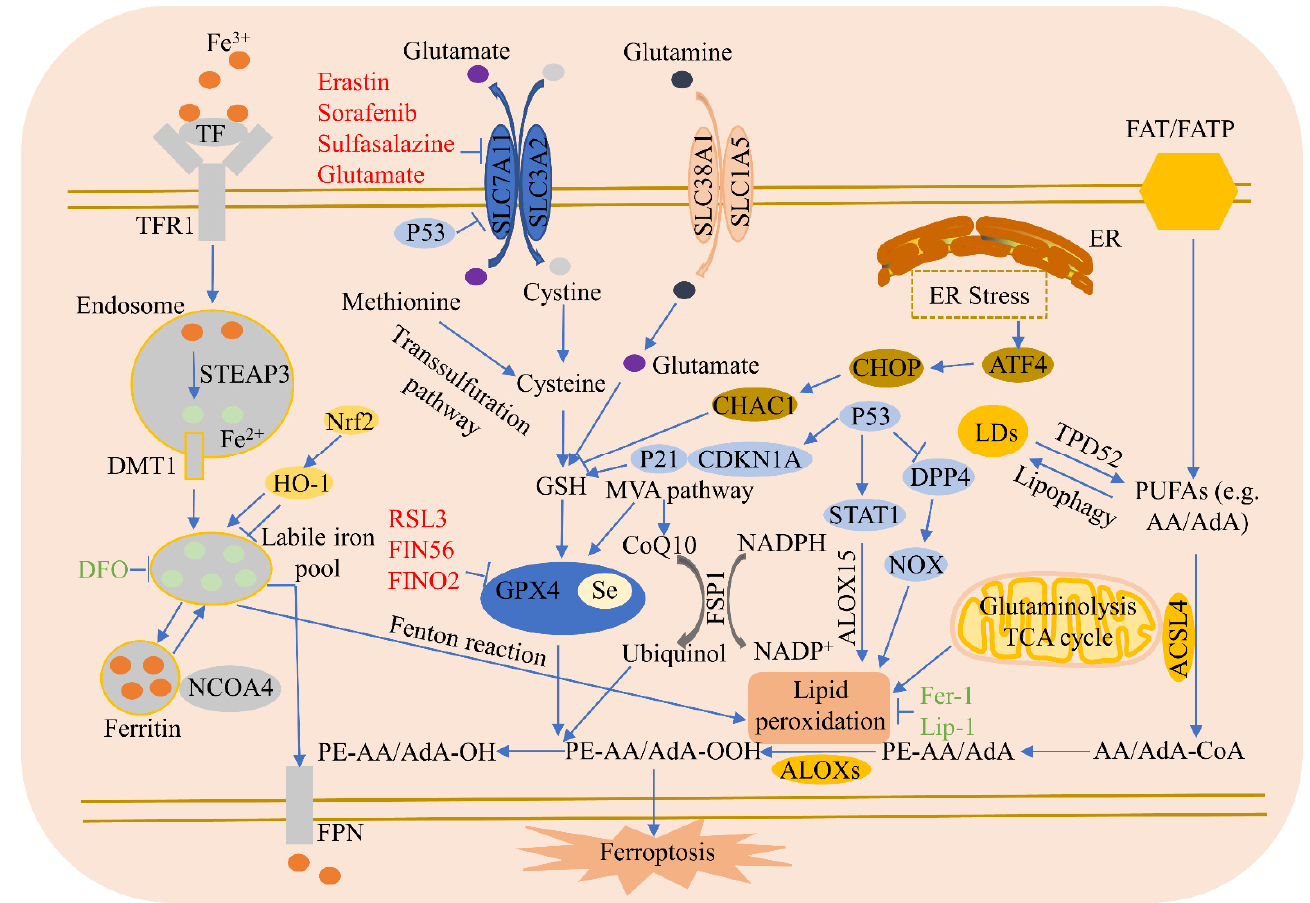
Figure 1. Ferroptosis regulatory pathways. Ferroptosis regulatory pathways can be roughly classi- fied into three types: The first involve iron metabolism, including the nuclear receptor coactivator 4 (NCOA4) regulation of ferritin degradation, and the Nrf2-HO-1 pathway, which affects iron. The second is the GSH/GPX4 pathway, including system Xc- inhibition, the transsulfuration pathway, mevalonate pathway (MVA pathway), glutamine pathway, and p53. The third type is that of lipid metabolism, including ACSL4, P53/SAT1/ALOX15, TPD52, and lipophagy, which are related to lipid regulation and ferroptosis, as well as the FSP1-CoQ10-NAD(P)H pathway synergies with GPX4 and GSH, which reduce phospholipid peroxidation and ferroptosis. In addition, endoplasmic reticulum (ER) stress facilitates ferroptosis via ATF4-induced CHAC 1 expression.